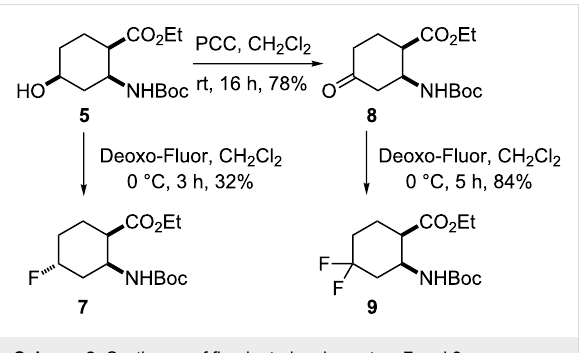
hydroxy function on position 4 (for analogous transformations, see reference